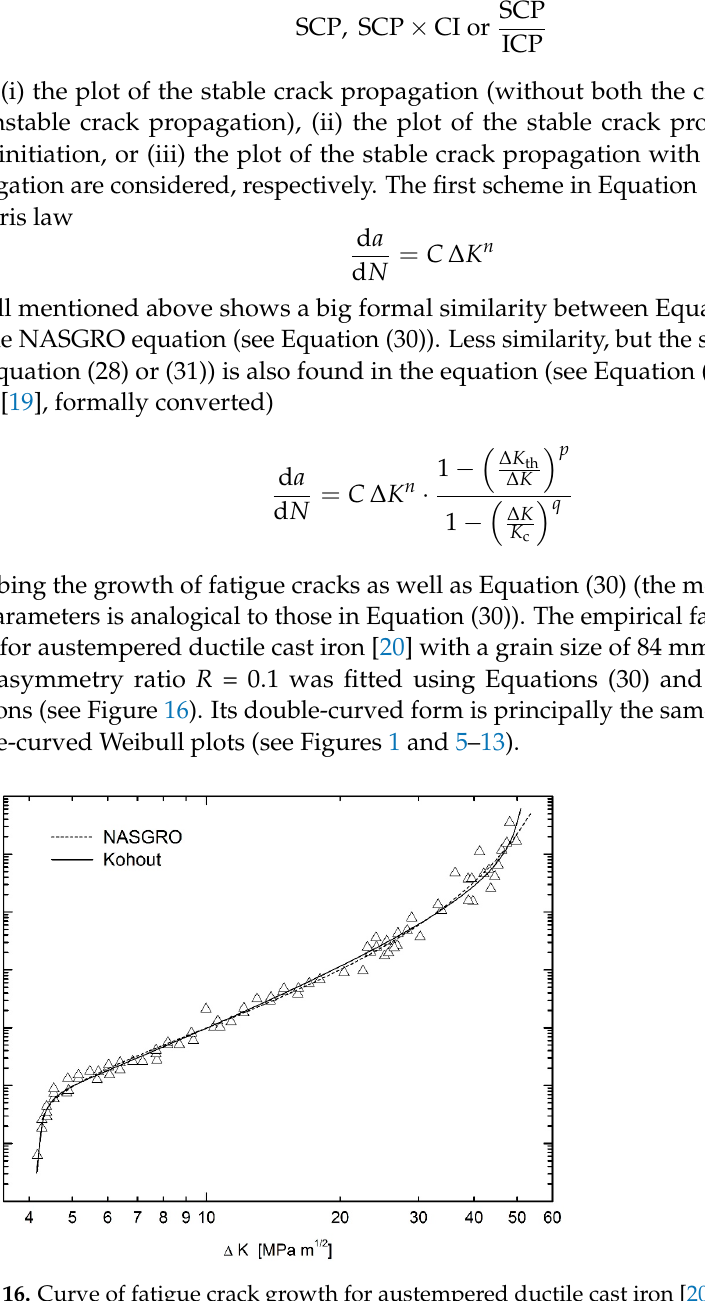
Figure 16. Curve of fatigue crack growth for austempered ductile cast iron [20] with a grain size of 84 mm loaded at loading cycle asymmetry ratio R = 0.1. Regression functions (30) (dashed line) and (34) (solid line) were used for fits.